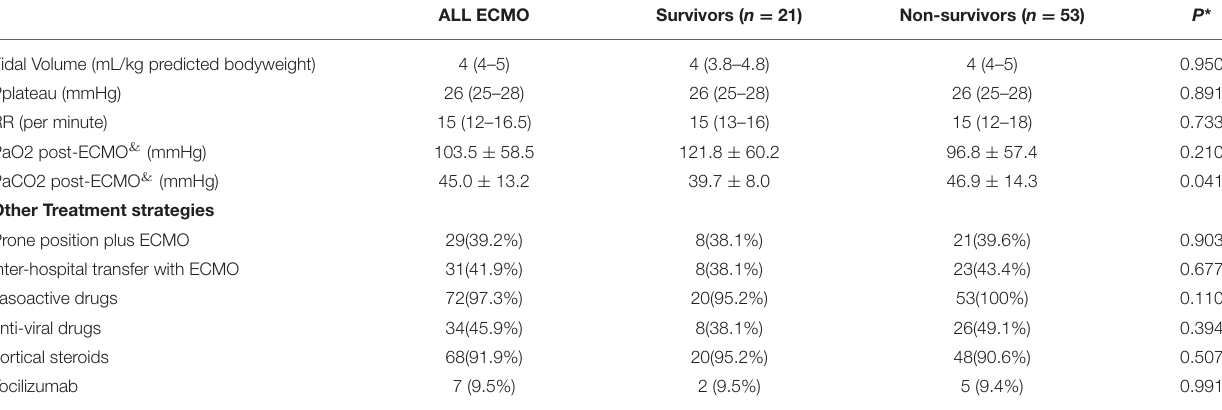
TABLE 4 | Multivariate Logistic regression analysis of variables affecting prognosis of ECMO patients.